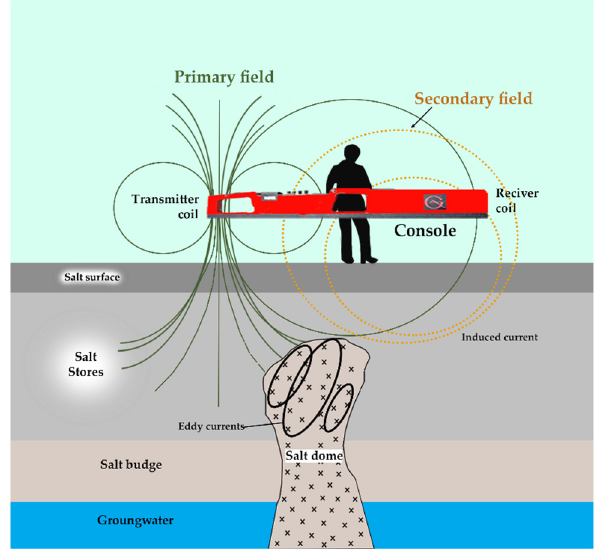
Figure 1. The signal generation and the response of the EM sensors (Modified from De Carlo et al. [33]).